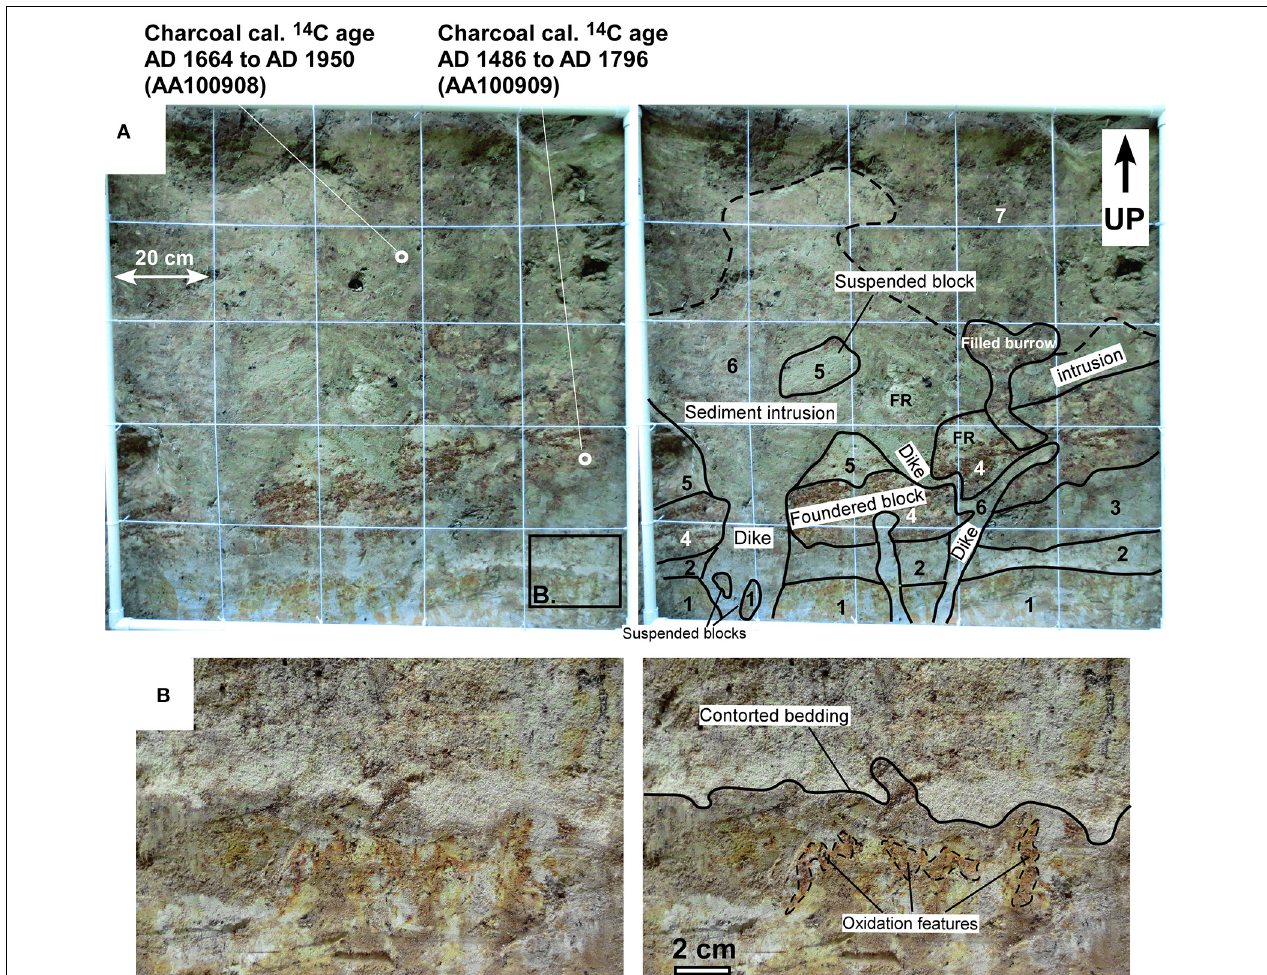
FIGURE 6 | SiteK(ClearCreek,33.52055 ◦ N,91.836 ◦ W)—Topisup. Location of (B) is shown on (A) . (A) Uninterpreted (left) and interpreted (right) photograph of 1 × 1m grid on vertical excavation showing sand dikes and intrusions containing suspended blocks and a block foundered in response to sediment movement. We interpreted these features to be caused by ground shaking and liquefaction. Unit 1, Clear Creek overbank, silty clay; Unit 2, Structureless (liquefied?) fine sand; Unit 3, Structureless (liquefied?), fine sand with clay inclusions; Unit 4, Clear Creek point-bar, thin-bedded oxidized